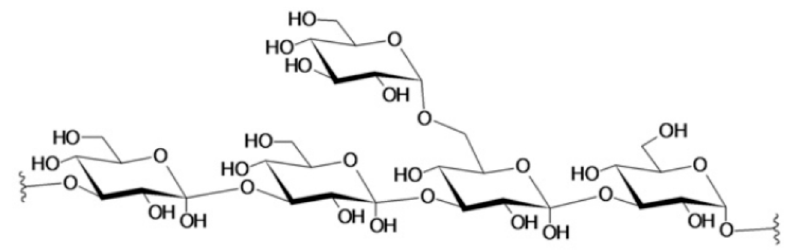
Figure 1. Reported chemical structure of laminarin extracted from Laminaria digitata [59].